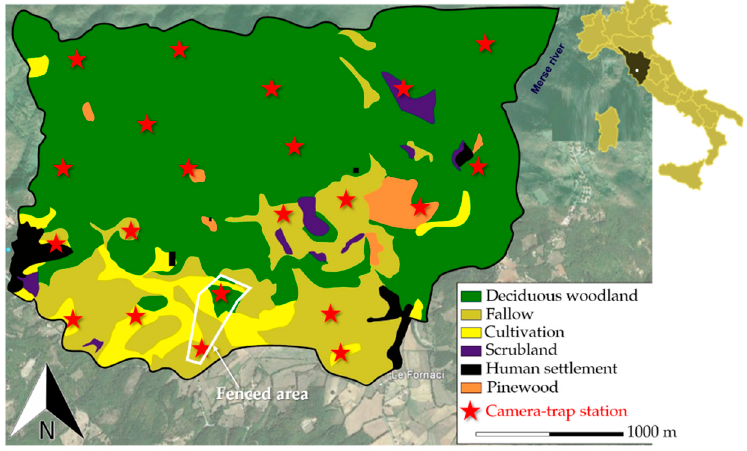
Figure 1. Location of the study area, habitat type composition, and position of camera-trap sta- tions.